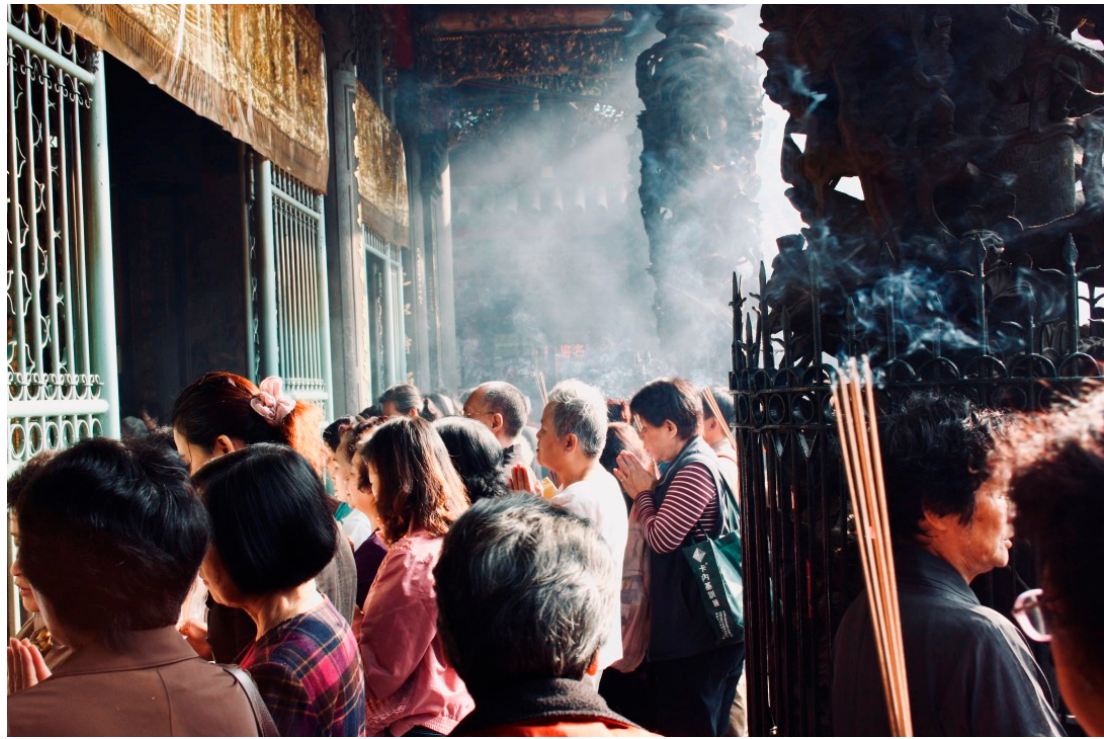
Figure 1. Devotees worshiping Guanyin at Longshan Temple, Taipei, 2014. Photo by Denis Byrne.